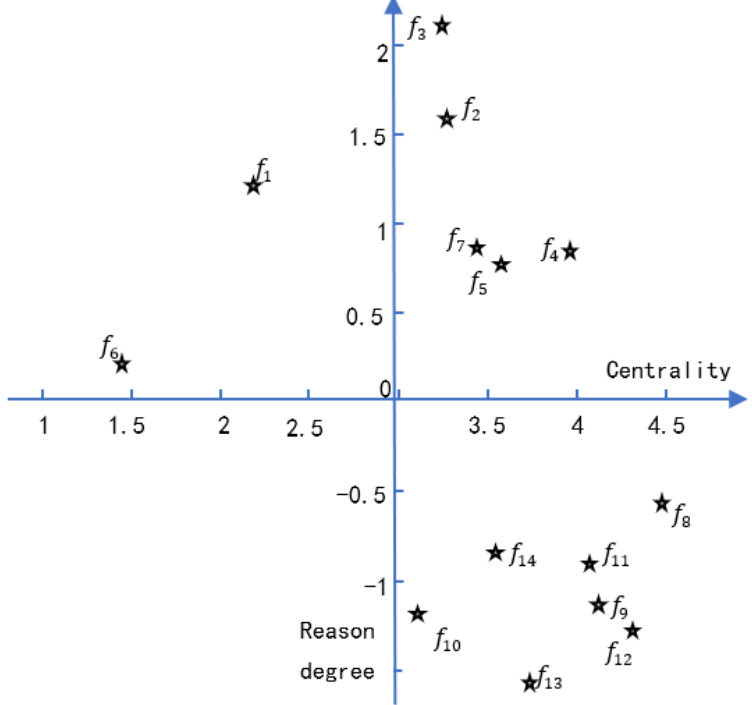
Figure 3. Schematic diagram of comprehensive impacting factors.